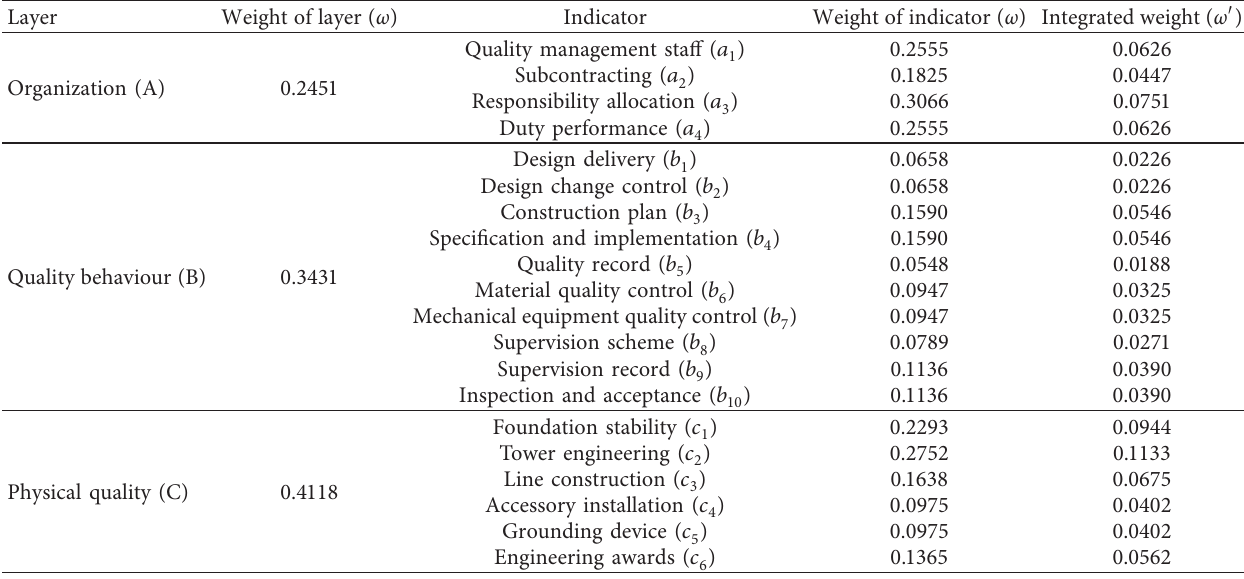
Table 5: Construction quality management standardized evaluation indicator weights and integrated weights.